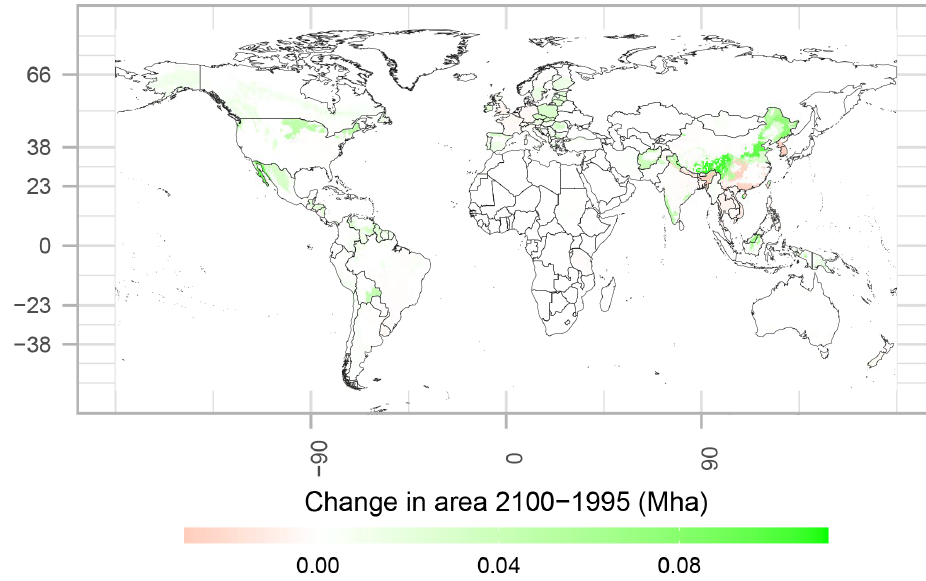
Figure 12. Difference in cellular plantation area between 1995 and 2100 for the MAgPIE forestry scenario (in Mha).